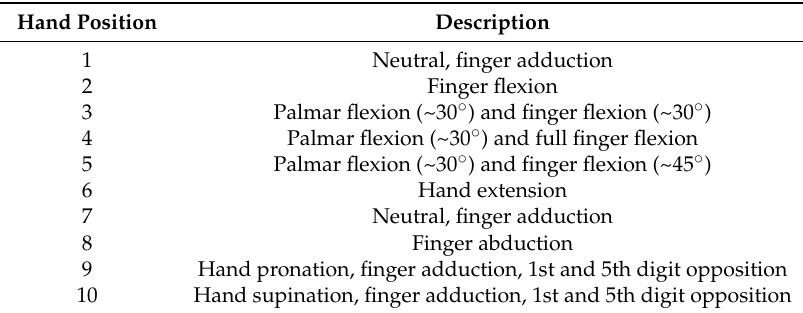
Table 3. Anatomical description of hand positions definitions.